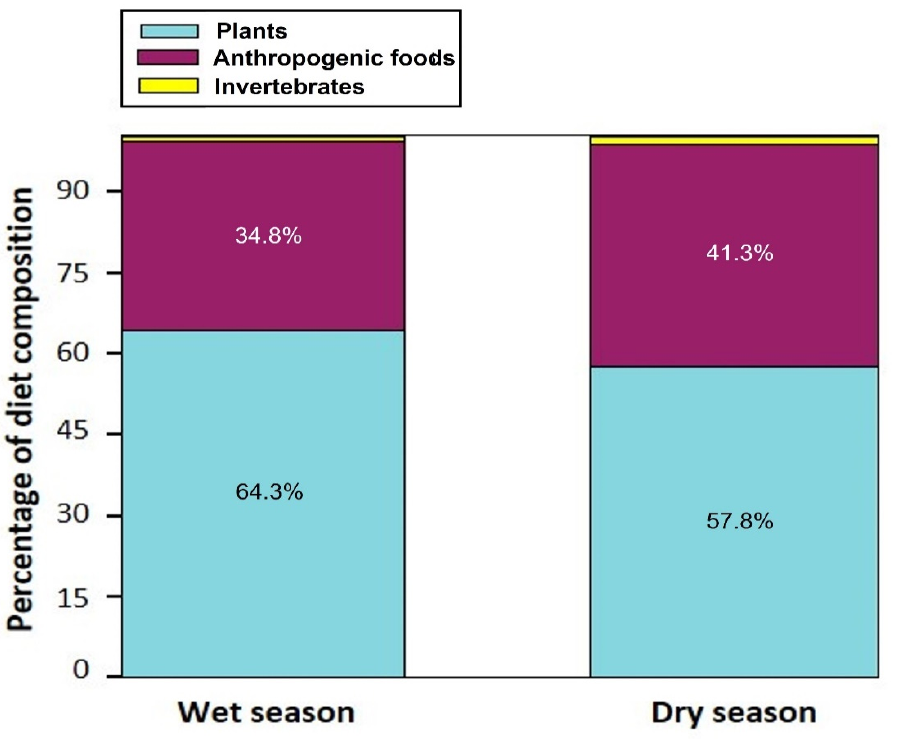
Figure 3. Percentage composition of plant, anthropogenic food, and invertebrates in the diet of Lowe’s monkeys in the wet and dry seasons at Duasidan Monkey Sanctuary, Ghana (Wilcoxon rank sum test: p > 0.05).